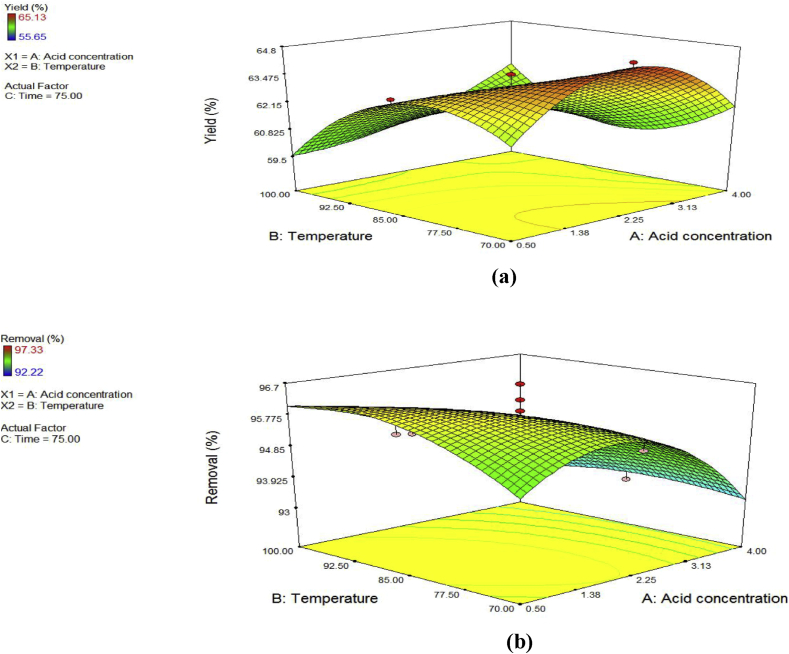
Effect of acid concentration and temperature on percentage (a) yield and (b) Pb2+ removal on HCl activated Aloji clay (constant time = 75 min).